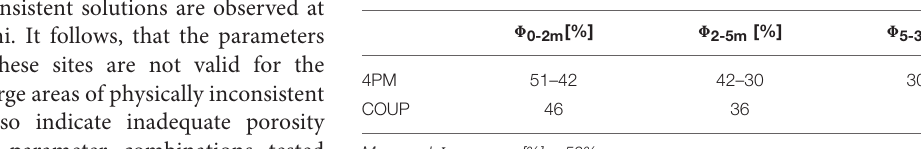
TABLE 3 | Summary of the porosities used in the 4PM and COUP